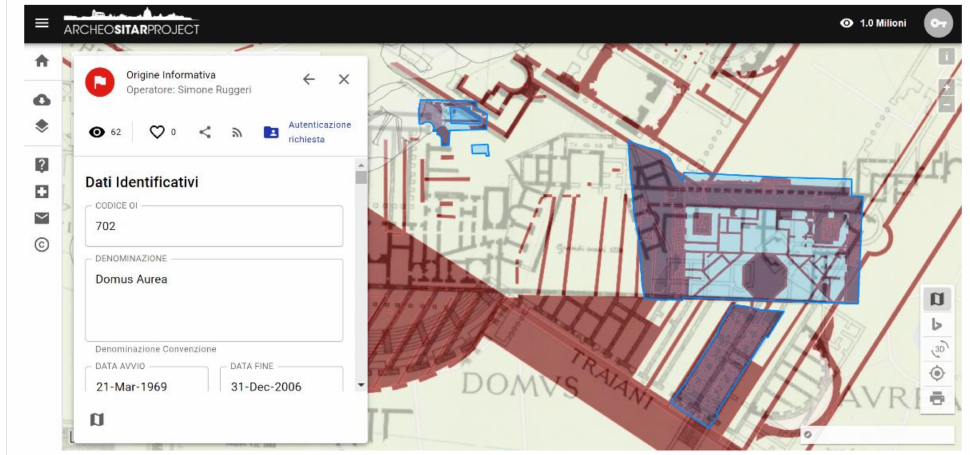
Figure 4. Italy SITAR project: graphic illustration of “Domus Aurea” on the map associated with the